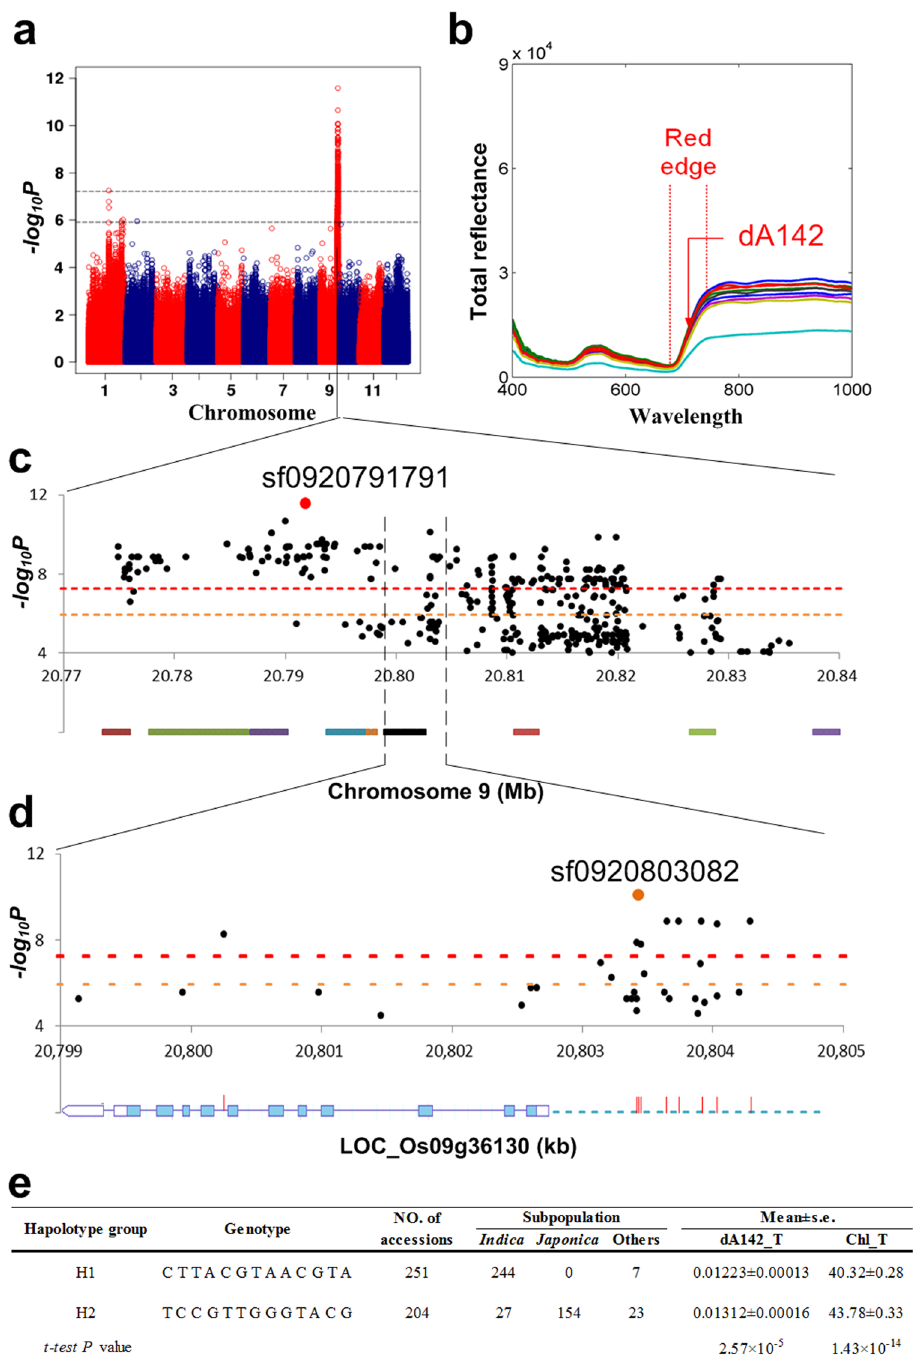
Figure 4. Candidate gene identification of loci associated with the red edge-related index dA 142 (genetically and phenotypically correlated with Chl) at the tillering stage. ( a ) Manhattan plot of index dA 142 . ( b ) Total reflectance values ranging from 400 to 1,000 nm of 10 accessions at the tillering stage. ( c ) The 70- kb region around the lead SNP sf0920791791. The red/orange horizontal dashed lines indicate the significant/suggestive P -value thresholds. The bars with different colors at the bottom represent the genes in the genomic region. ( d ) The 6- kb region containing the gene LOC_Os09g36130. Regarding the gene structure at the bottom, the red lines, blue dashed lines, purple lines, white box, and blue box indicate significant SNPs, a promoter region, an intron, an untranslated region (UTR), and an exon, respectively. ( e ) Haplotype analysis of the candidate